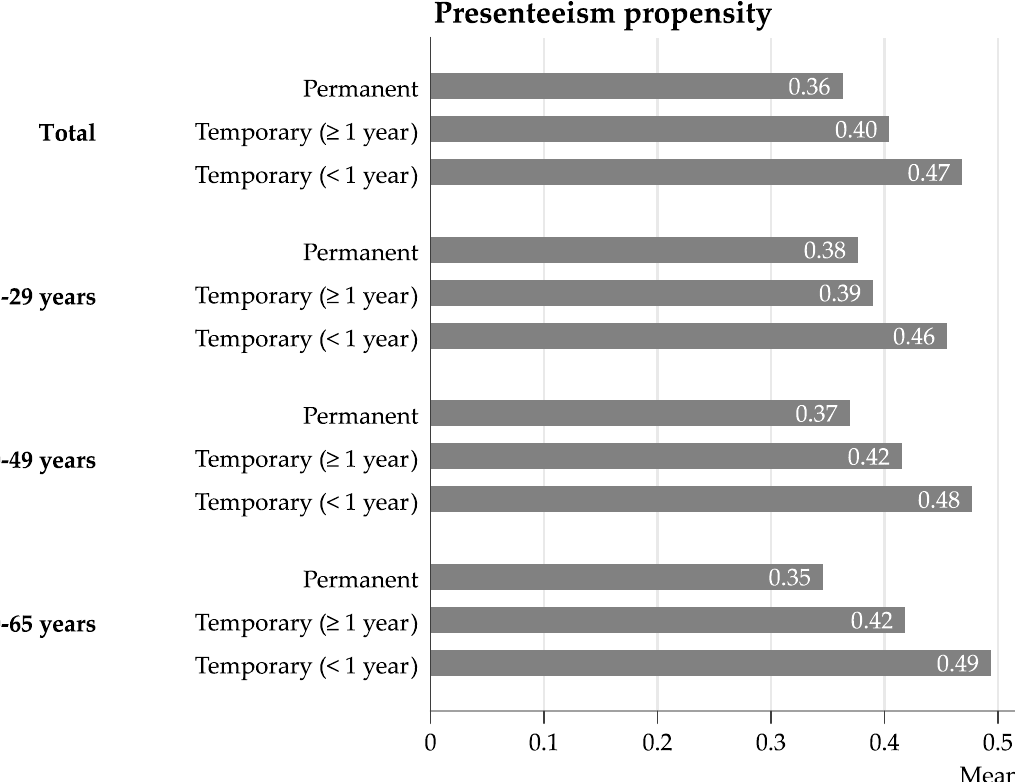
Figure 2. Predicted presenteeism propensity by employment contract in different age groups. Propensities adjusted for country, sex, job tenure, working hours, income, occupation, working sector, company size and number of health events.